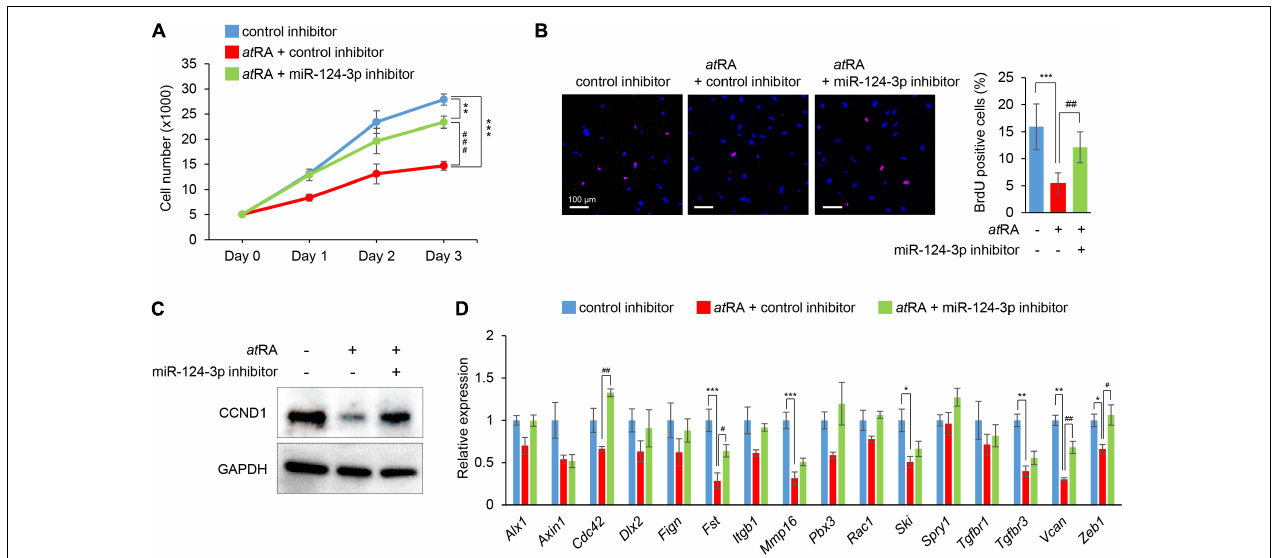
FIGURE 4 | Normalization of miR-124-3p expression restores at RA-induced cell proliferation defect in MEPM cells. (A) Cell proliferation assays in MEPM cells treated with a control or a miR-124-3p inhibitor under the 30 µ M at RA condition for 0, 24, 48, or 72 h (Days 0–3). Two-way ANOVA with Tukey’s honest significant difference test ( n = 6 per group). ** p < 0.01, *** p < 0.001, ### p < 0.001. (B) BrdU staining (red) in MEPM cells after treatment with/without a miR-124-3p inhibitor under the 30 µ M at RA condition for 72 h. Nuclei were counterstained with DAPI (blue). Representative images from two independent experiments are shown. Graph shows the quantification of BrdU-positive cells. One-way ANOVA with Tukey’s honest significant difference test. *** p < 0.001 vs. control inhibitor + vehicle, ## p < 0.01 vs. control inhibitor + at RA. Bars, 50 µ m. (C) Immunoblotting analysis of CCND1 and GAPDH in MEPM cells treated with 30 µ M at RA under the effect of a miR-124-3p inhibitor for 72 h. Representative images from two independent experiments are shown. (D) Quantitative RT-PCR for the indicated genes in MEPM cells after treatment with at RA under the effect of a miR-124-3p inhibitor for 24 h. *Adjusted p < 0.00313 (16 genes), **adjusted p < 0.000625 (16 genes), and ***adjusted p < 0.0000625 (16 genes) vs. control inhibitor + vehicle. # Adjusted p < 0.00313 (16 genes), ## adjusted p < 0.000625 (16 genes), and ### adjusted p < 0.0000625 (16 genes). Two-way ANOVA with Tukey’s honest significant difference test ( n =